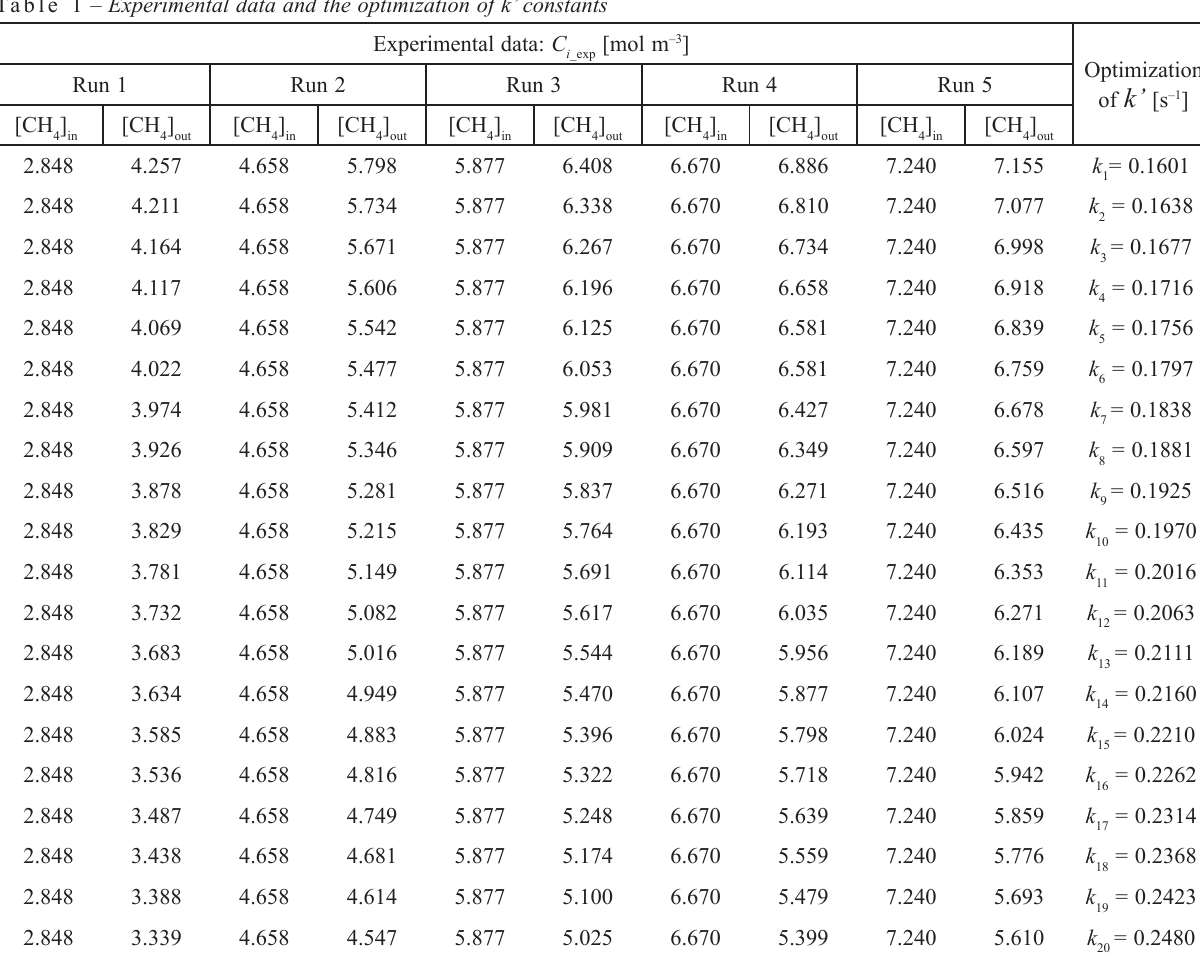
Table 1 – Experimental data and the optimization of k’ constants